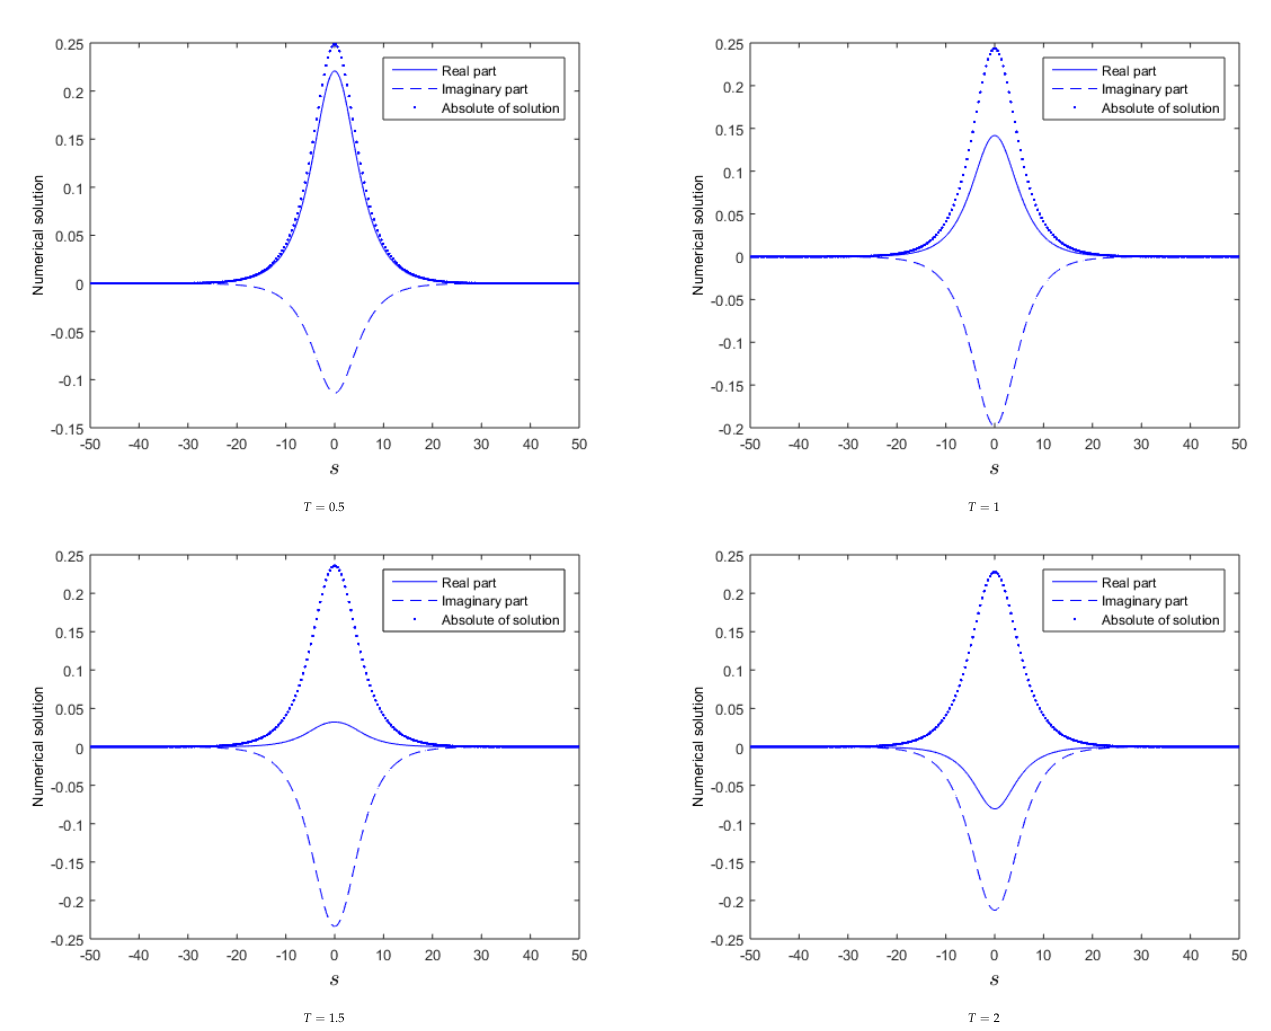
Figure 2. Profile of the numerical solutions at M = 128 and ∆ τ = 0.01 with different T for Test Problem 2. Table 6. Error norms and conservation laws at various time level with M = 128 and ∆ τ = 0.001